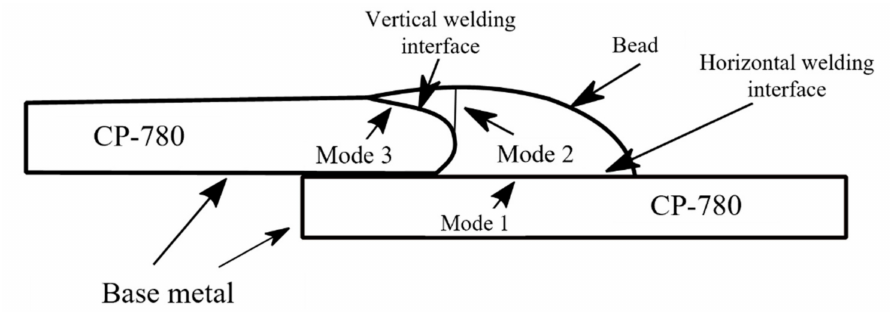
Figure 9. Failure modes in lap welded joints, adapted from